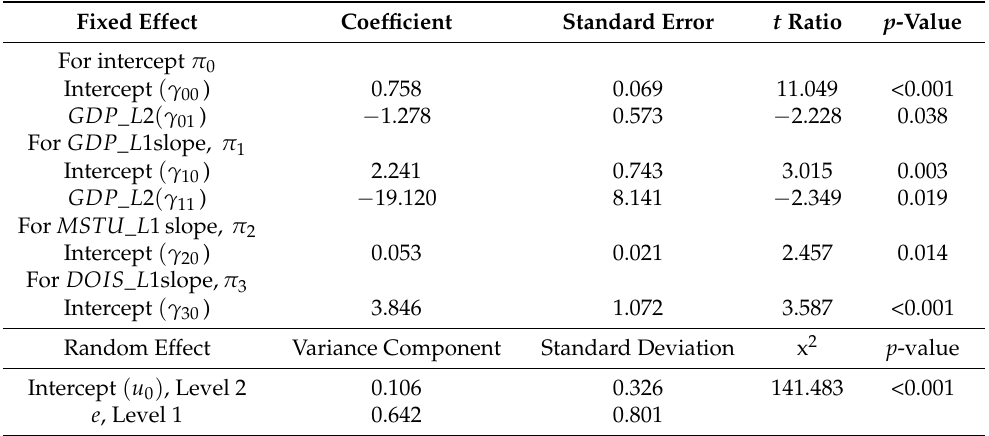
Table 5. Results of parameter and random intercept, fixed slope, and interaction effects model of fire occurrence